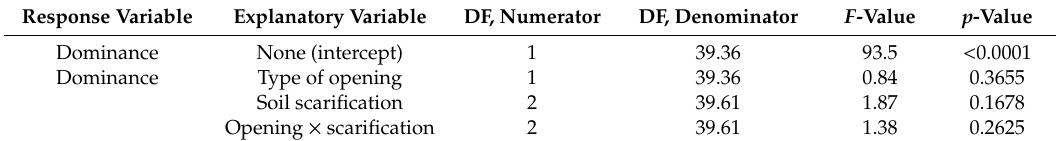
Table 5. Logistic regressions conducted on a binary response variable comparing the dominant species in year 2 with the dominant species in year 15 (1 = same dominant species; 0 = di ff erent dominant). Values from individual 6.25-m 2 quadrats were used, with a consequent random e ff ects structure (see Section 2 for details). DF, degrees of freedom.